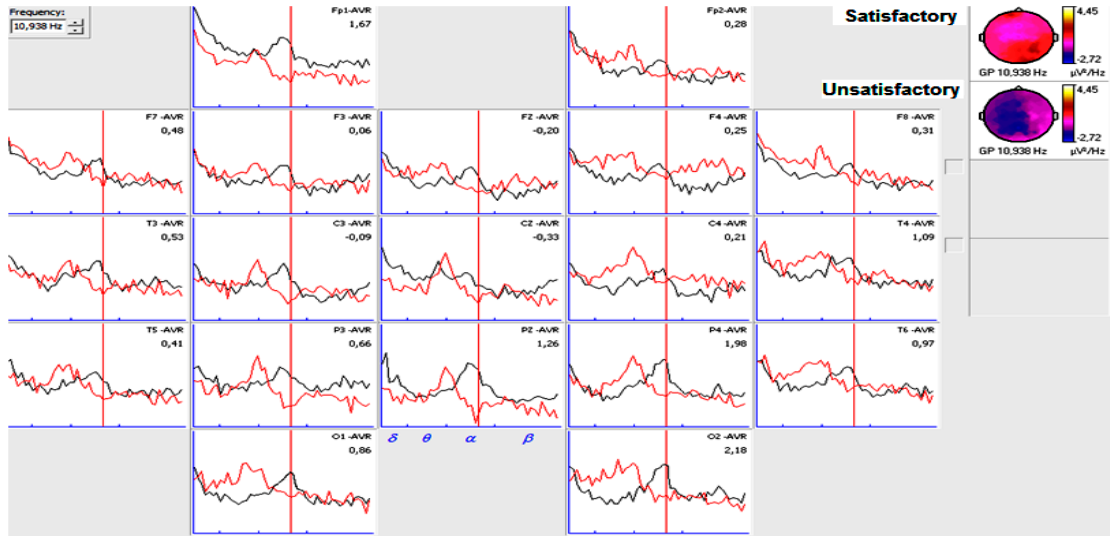
Figure 4. Band quantitative analysis in patients six months after surgery with epilepsy in the right temporal lobe and different evolution in the second year. Black spectrum (Frequency composition of a patient six months after surgery and satisfactory post-surgical evolution in the second year). Red spectrum (Frequency composition of a patient six months after surgery and unsatisfactory post-surgical evolution in the second year).